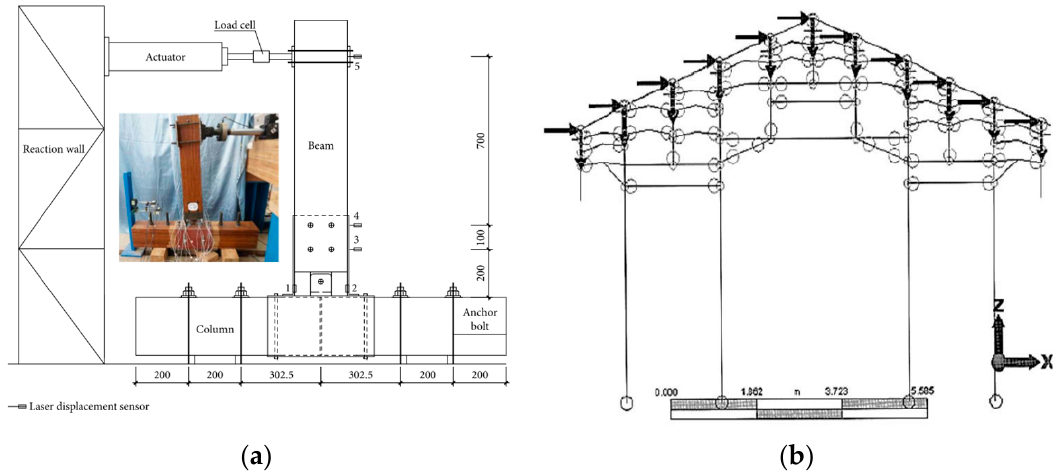
Figure 10. ( a ) Schematic diagram of the testing setup of a timber connection [65]. ( b ) Numerical model of a sample post and beam building with nonlinear springs [58].